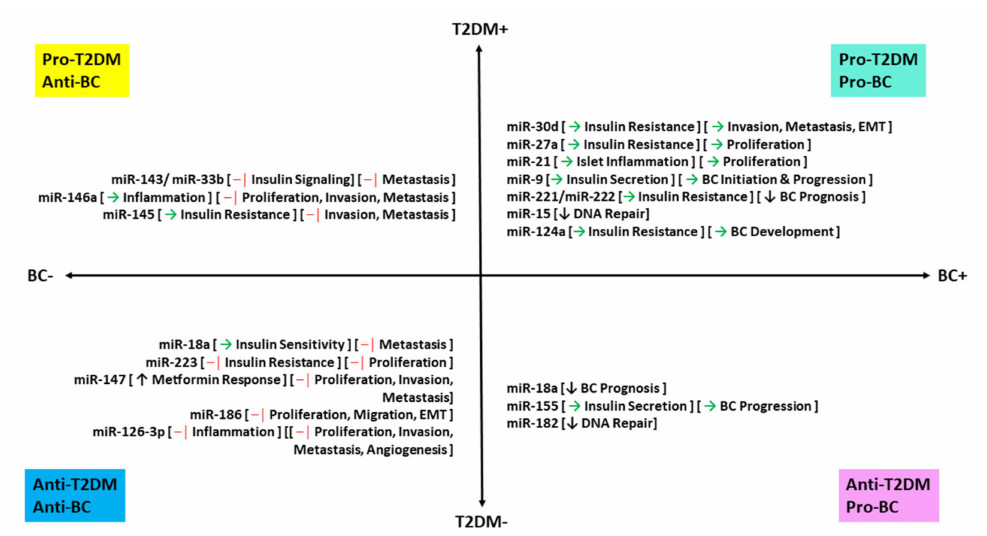
Figure 3. Regulatory miRNA overlap in T2DM and breast cancer. Symbols: → represents activation, – | represents inhibition, ↑ represents upregulation, and ↓ represents